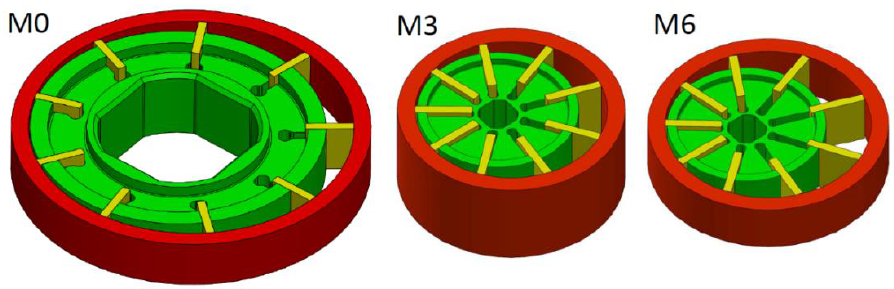
Figure 17. Rotating assembly of the unit M6, contrasted with the configurations M0 and M3.